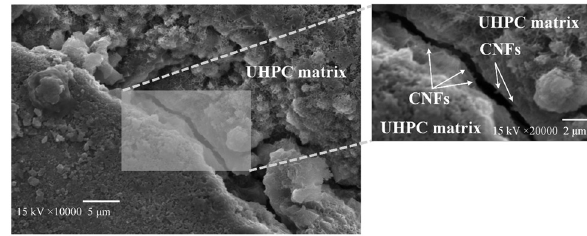
Figure 10: SEM image of 0.15% CNF. The image shows that CNFs bridged the crack within UHPC